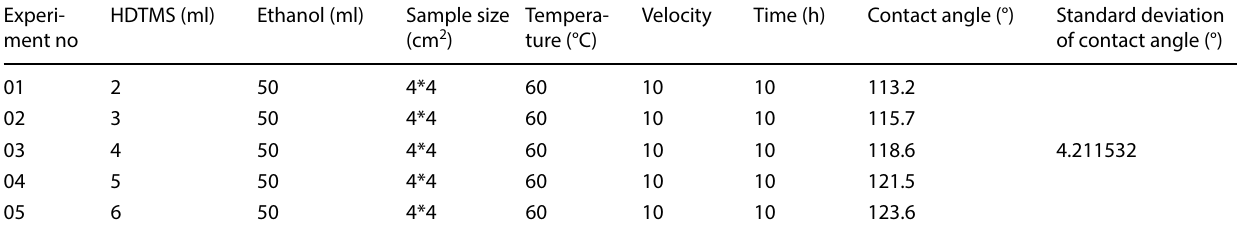
Table 3 Different contact angle for different amount of HDTMS within same parameters